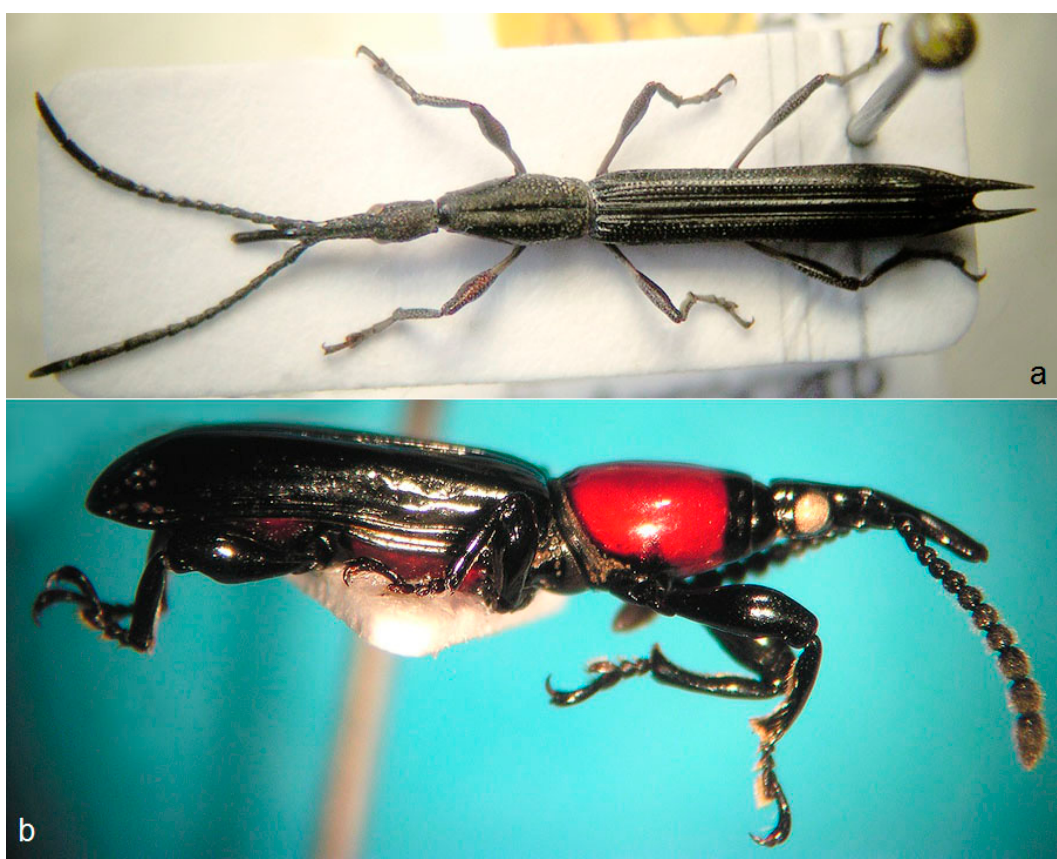
Figure 2. Achrionota sp. ( a ) and Homophylus sp. (both Brentidae) ( b ).